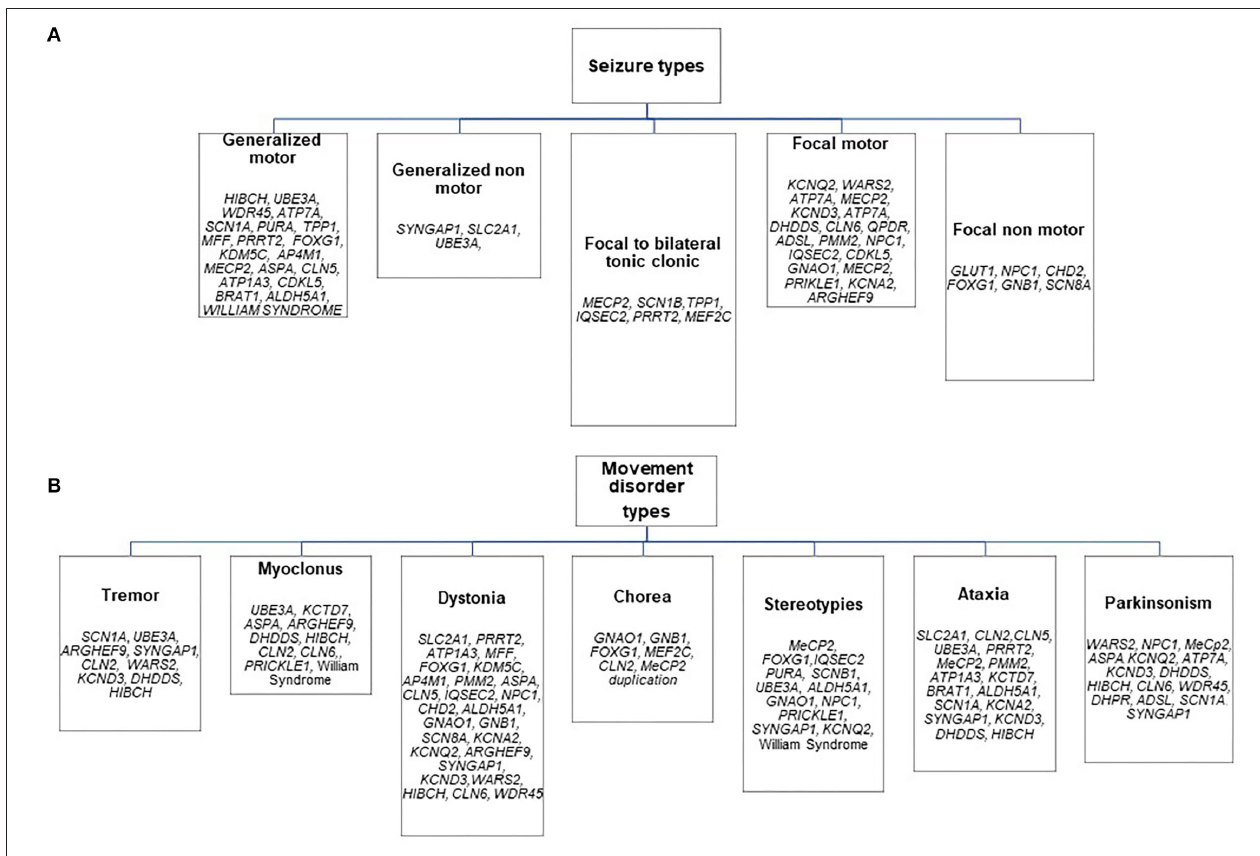
FIGURE 1 | Distribution of genetic etiologies according to presenting seizure (A) and movement disorder (B) types in the whole